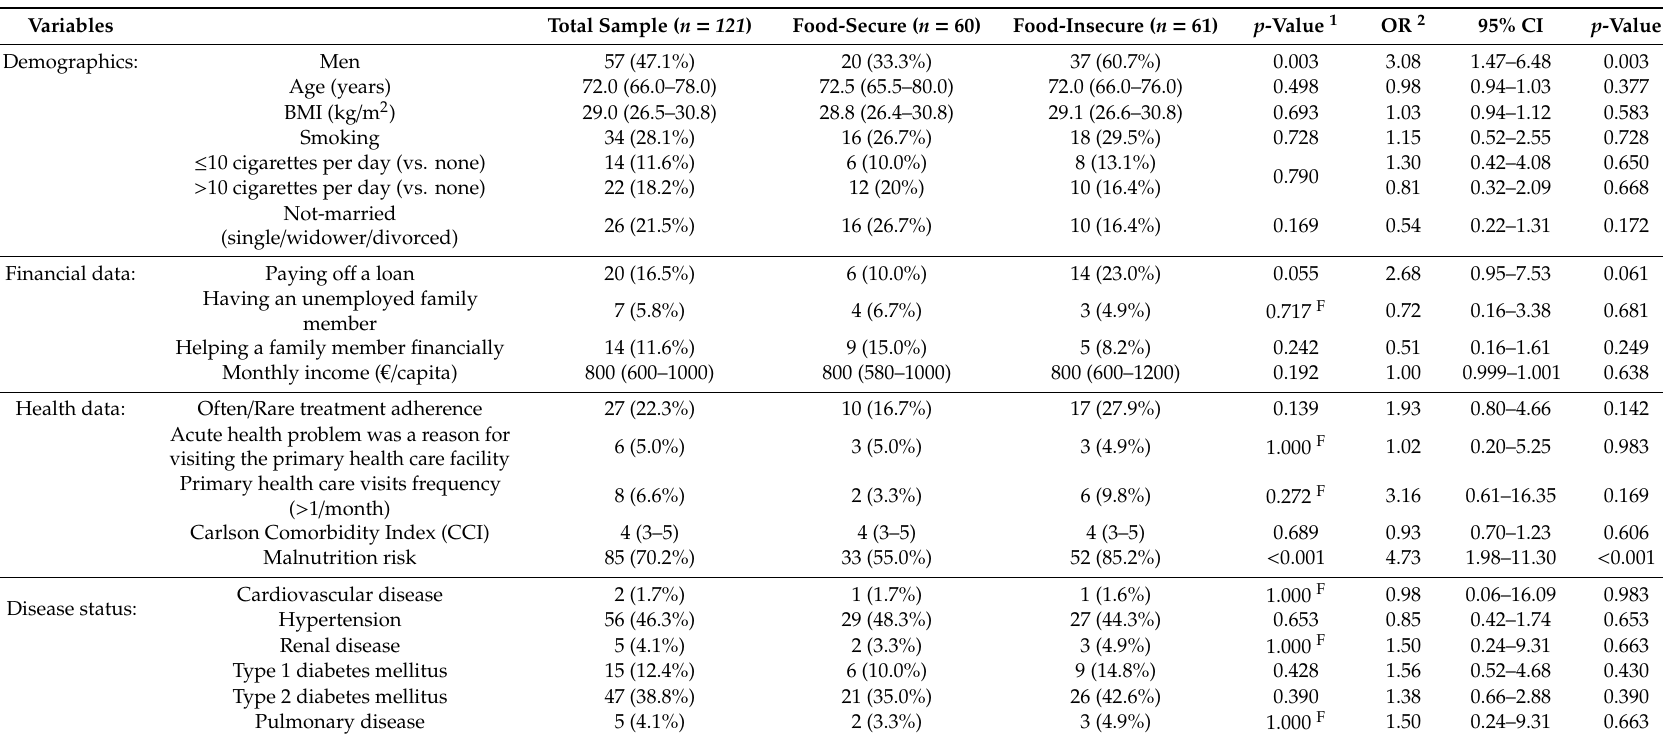
Table 1. Sample’s characteristics with a univariable assessment of food-secure versus food-insecure participants d